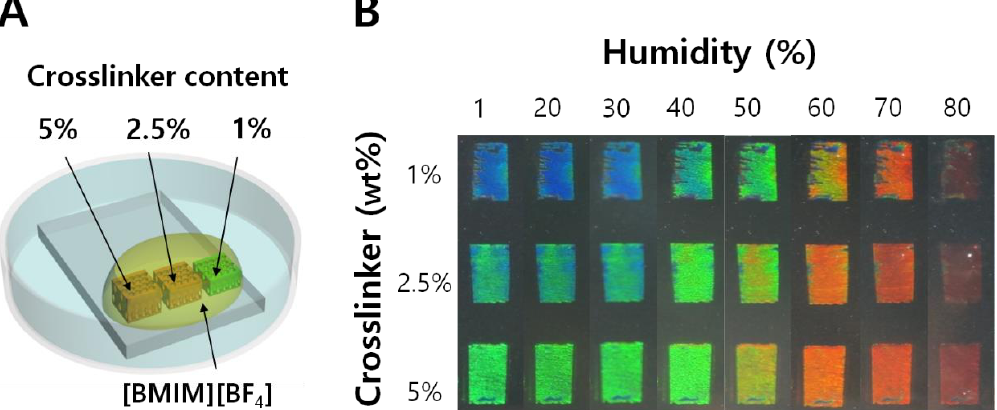
Figure 3. ( A ) Illustration showing three IOPGs with different crosslinker contents on a single substrate which are soaked in [BMIM + ][BF 4 − ] IL; ( B ) Humidity-dependent color changes of three PHEMA IOPGs with crosslinker contents of 1%, 2.5%, and 5%. Upon variations of relative humidity from 1% to 80% RH, a less-crosslinked (1% EGDM content) IOPG shows entire visible color ranges.